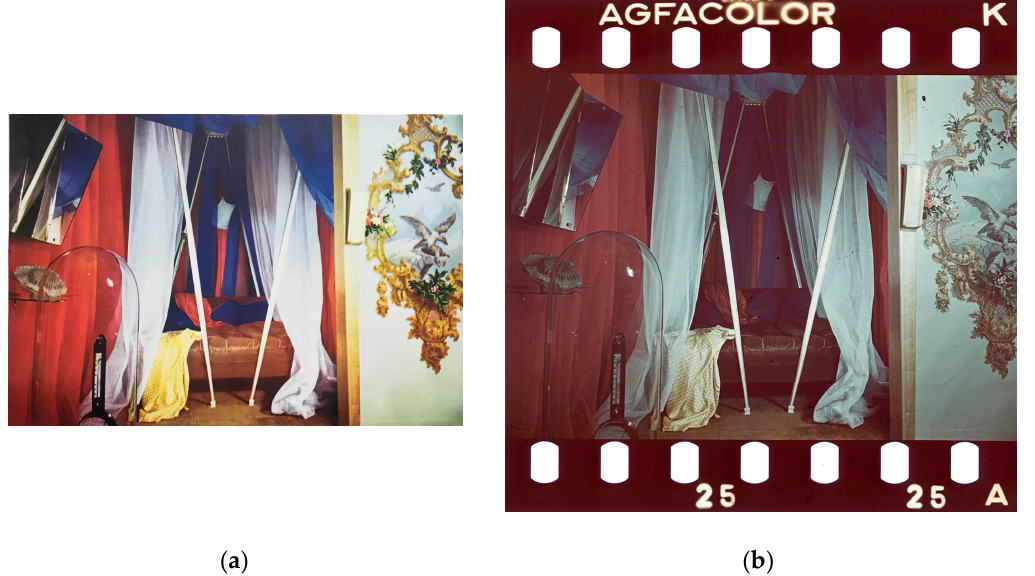
Figure 5. ( a ) Photograph of the mock up of the bedroom for a farmhouse in the rice fields as published in Domus 181; ( b ) ACM photograph 1.II.18: Photograph out of a nearly identical series of photographs held at the Carlo Mollino